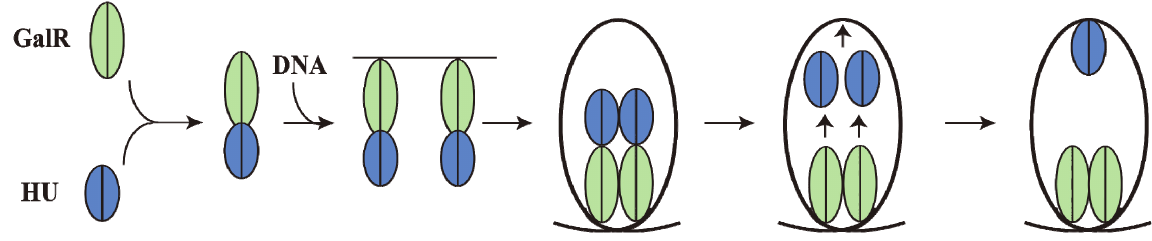
Figure 14. Pathway of Repressosome formation. GalR (light green) and HU (blue) first bind together, then bind to the DNA, resulting in DNA loop formation with HU dissociating from GalR and binding to the apex of the DNA stabilizing the loop involving GalR-GalR interactions (adapted from